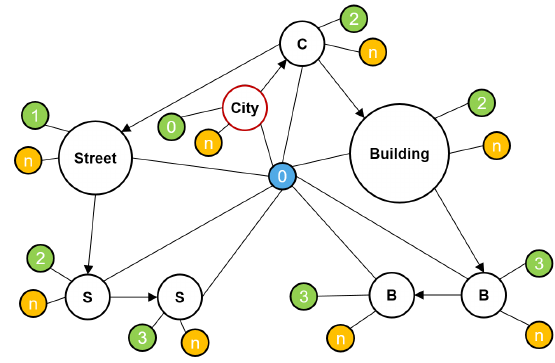
Figure 4. EXAMPLE: LOD-graph using new object-model; green nodes: spatial parts with dimension; blue node: time-stamp with dimension; orange nodes: thematic parts with n dimensions; white nodes: cells (red boundary: root